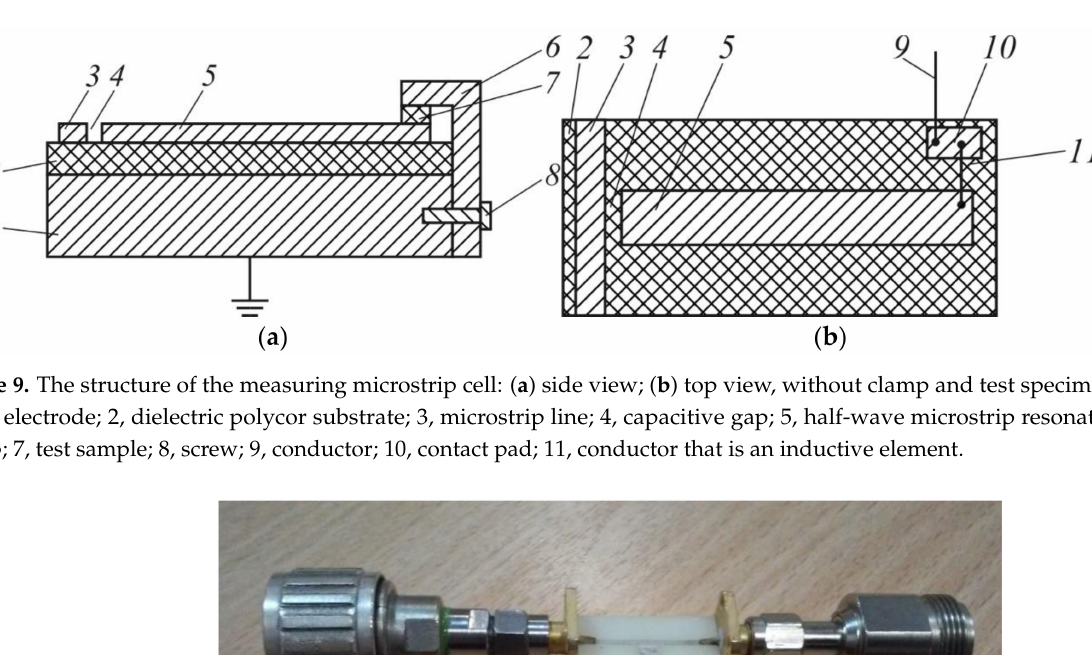
Figure 8. Flowchart of connecting a panoramic meter for measuring: ( a ) The parameter S 21 ; ( b ) S 11 . XW1, coaxial cable; W1, directional waveguide of the incident wave; W2, directional waveguide of the reflected wave; A1, measuring waveguide section with the sample; XW2, matched load; Inc., incident wave; Refl., reflected wave; ARM, system of automatic power control.